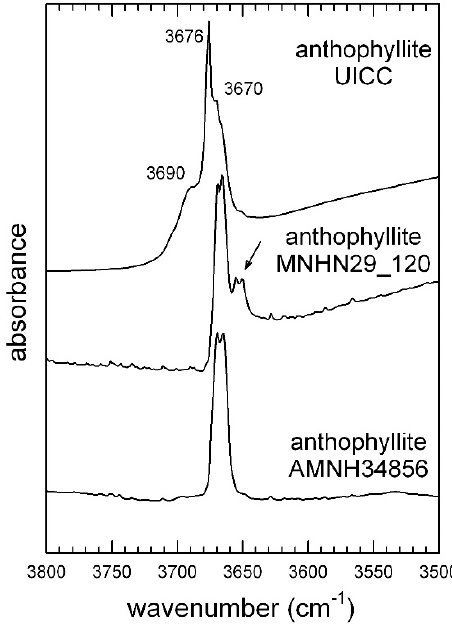
Figure 3. FTIR OH-stretching spectra of the studied UICC standard anthophyllite Finnish NB #4173-111-5 compared to sample MNHN29_120 and anthophyllite AMNH34856.